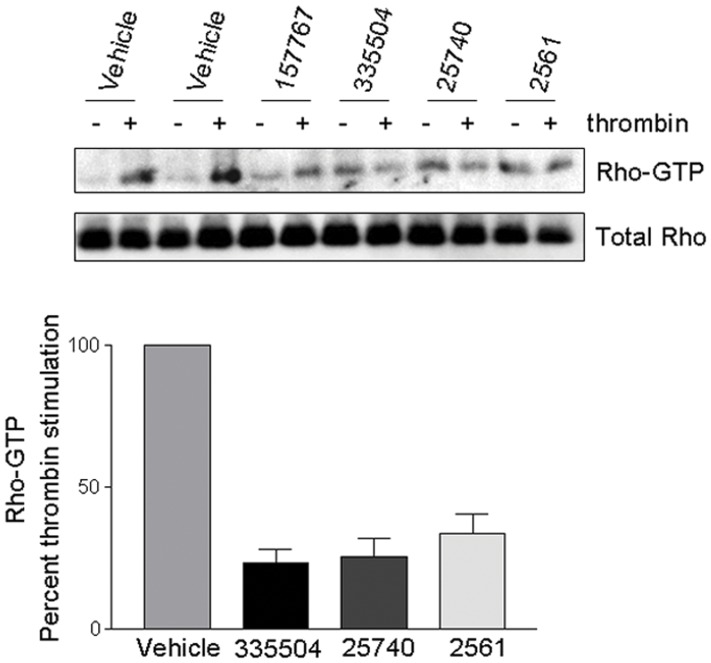
Putative Rho compounds inhibit thrombin stimulated RhoA activation in glioblastoma cells.Compounds were selected from a pocket directed virtual screen and tested on Glioblastoma cells (1321N1). Cells were pre-treated for 1 hr with either DMSO control or 30 µM of compound 157767, 335504, 25740 or 2561 and subsequently stimulated for 15 minutes with either vehicle or 0.5 U/mL thrombin. RhoA activity was assessed via pull-down by rhotekin and total RhoA was determined using an anti-RhoA antibody. Bar graph shows densitometric results from 4 independent experiments. Data are presented as means ± SEM; *P<0.001 vs. vehicle control, one-way ANOVA.